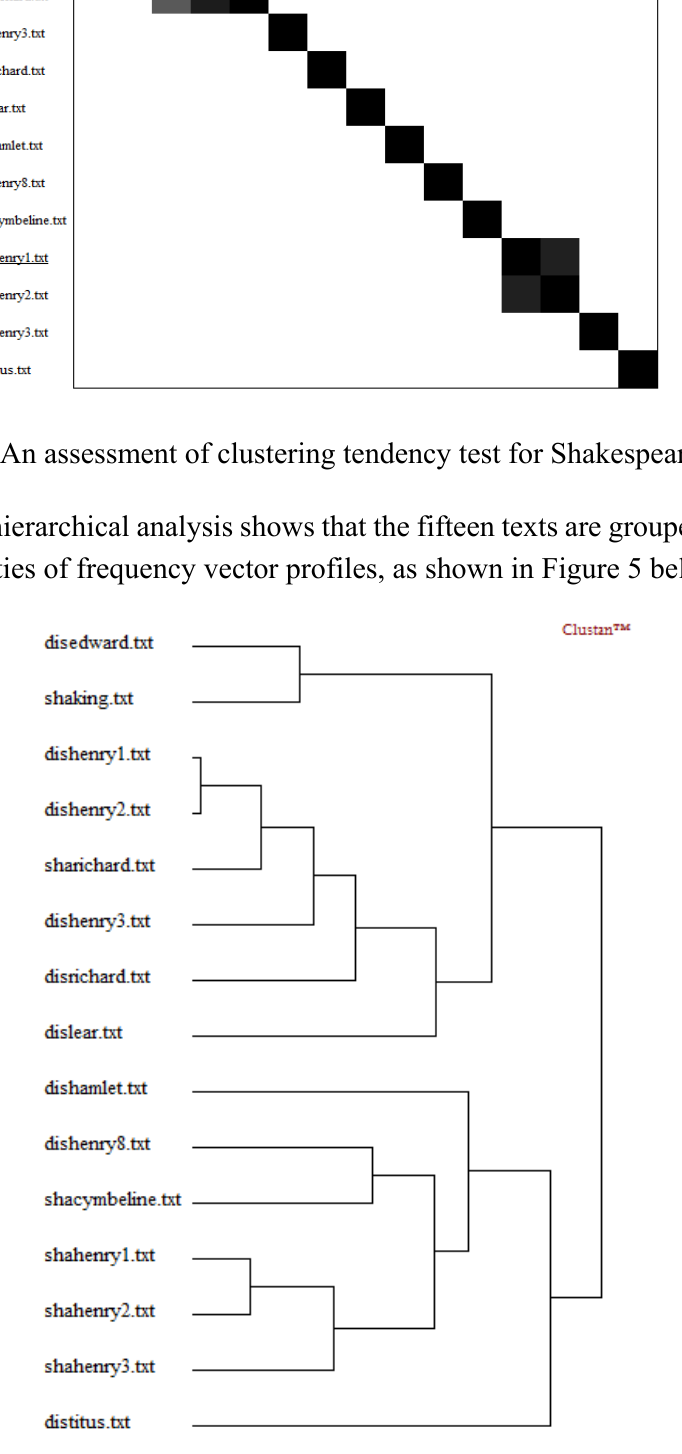
Figure 5. The hierarchical cluster analysis of Shakespeare D FW using Product-Moment correlation and Mean